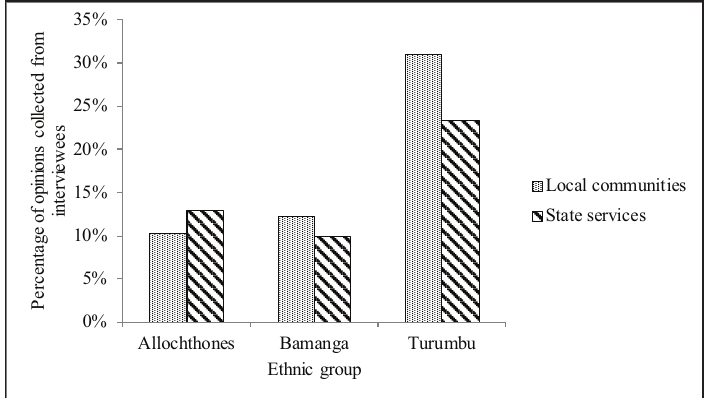
Figure1. Perceptions of actors involved in the management of Yangambi Biosphere